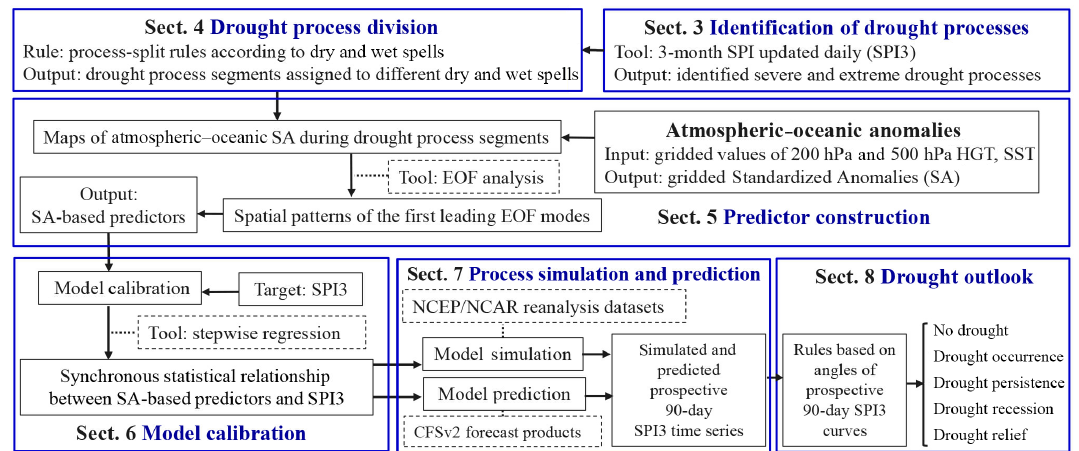
Figure 1. A brief introduction of the sequential procedures described in the sections of this study for drought prediction model construction.